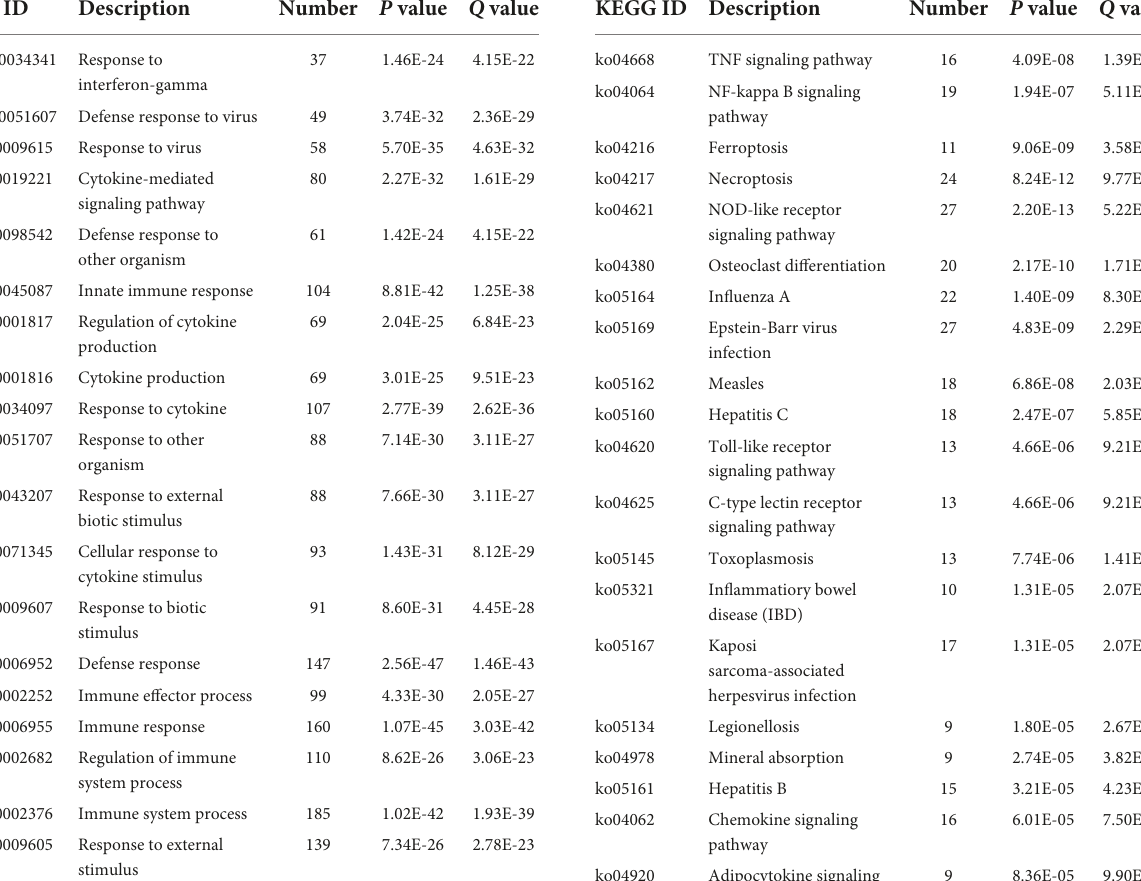
TABLE 2 GO enrichment analyses results. TABLE 3 KEGG enrichment analyses